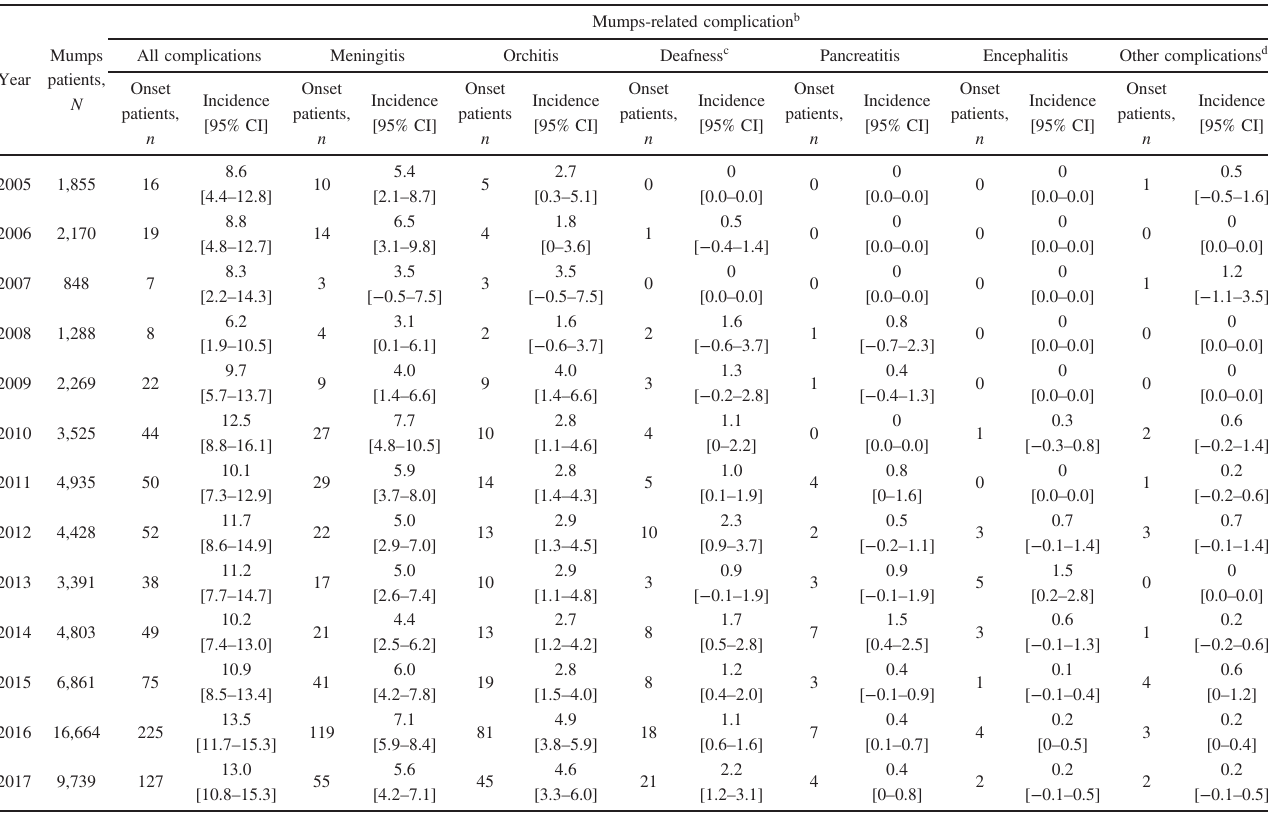
Table 3. Annual incidence of mumps-related complications [95% CI] in males and females aged 0 – 64 years, based on the